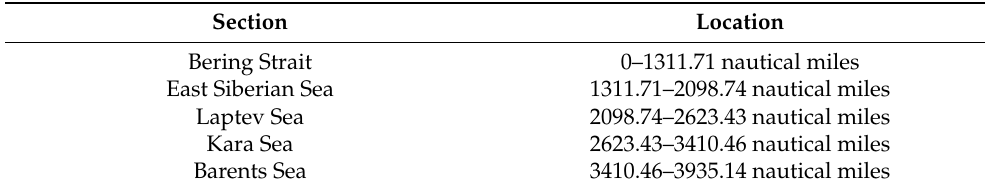
Table 1. Section division of the